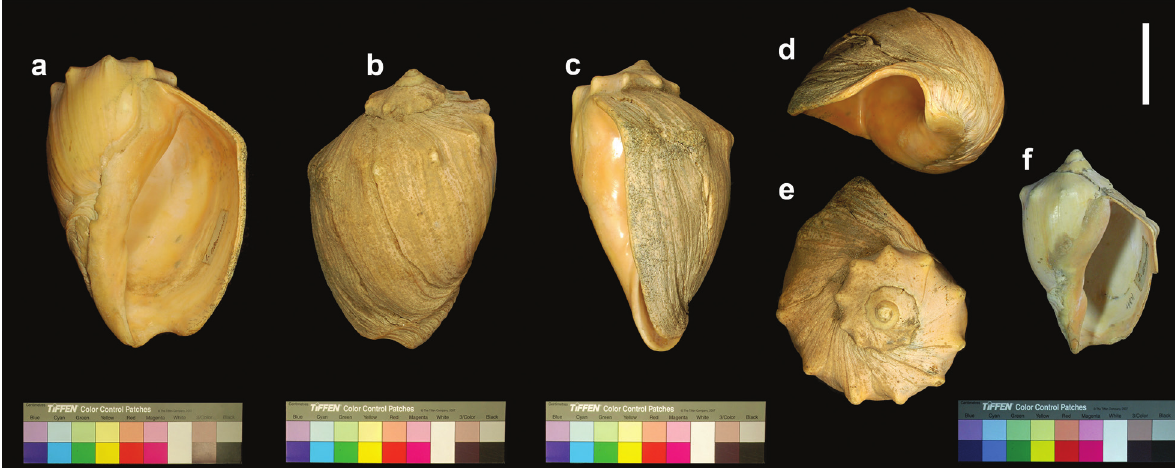
Figure 29. Voluta colocynthis alternata , specimens not figured by Lahille (1895). a–e Specimen 1 a Apertural view b Dorsal view c Lateral view d Umbilical view e Apical view f Apertural view of specimen 2. Scale bar: 5